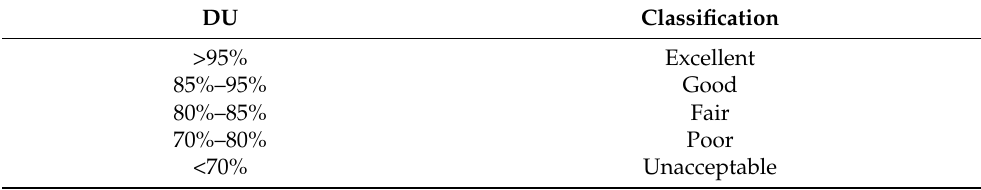
Table 2. Classification of distribution uniformity (DU) coefficient by Merriam and Keller